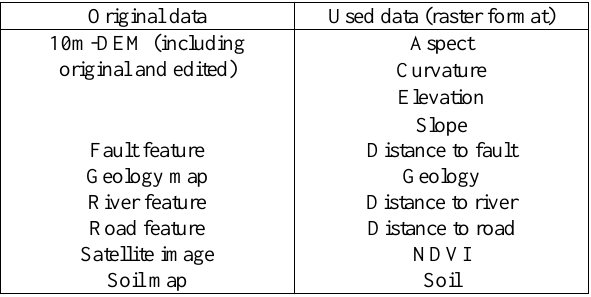
Table 1. The used landslide causative